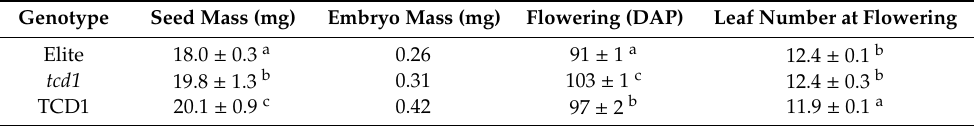
Table 1. Seedling and reproductive growth data of the selected three sorghum genotypes: Elite (parent line from which mutants are derived), totally cyanide deficient class 1 ( tcd1 ) mutant and sibling line of tcd1 mutant without the target mutation